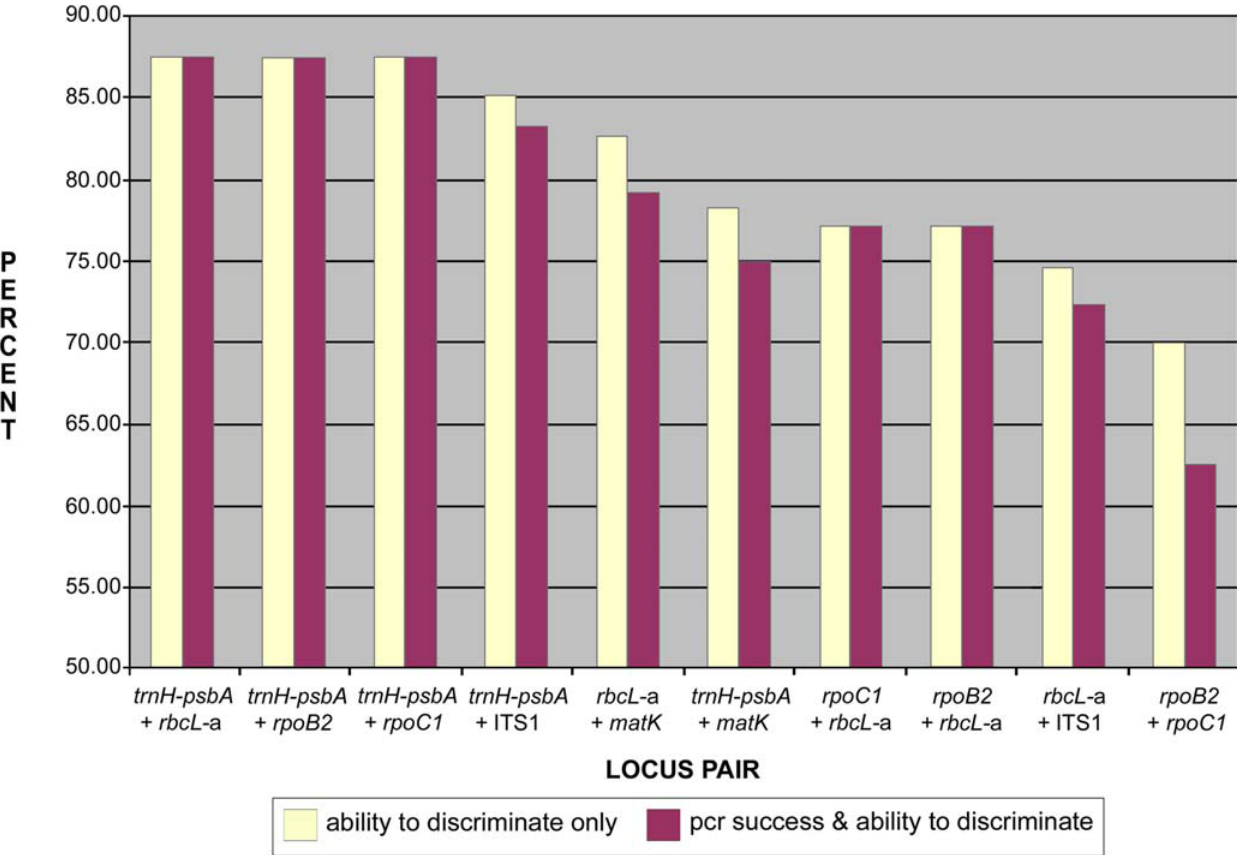
Figure 3. Properties of two-locus pairs tested as putative barcodes. Only those locus pairs with PCR success greater than 90% are included. Yellow bars indicate percent success in differentiating between species of a pair only; maroon bars indicate PCR success combined with the ability to differentiate between species of a pair.